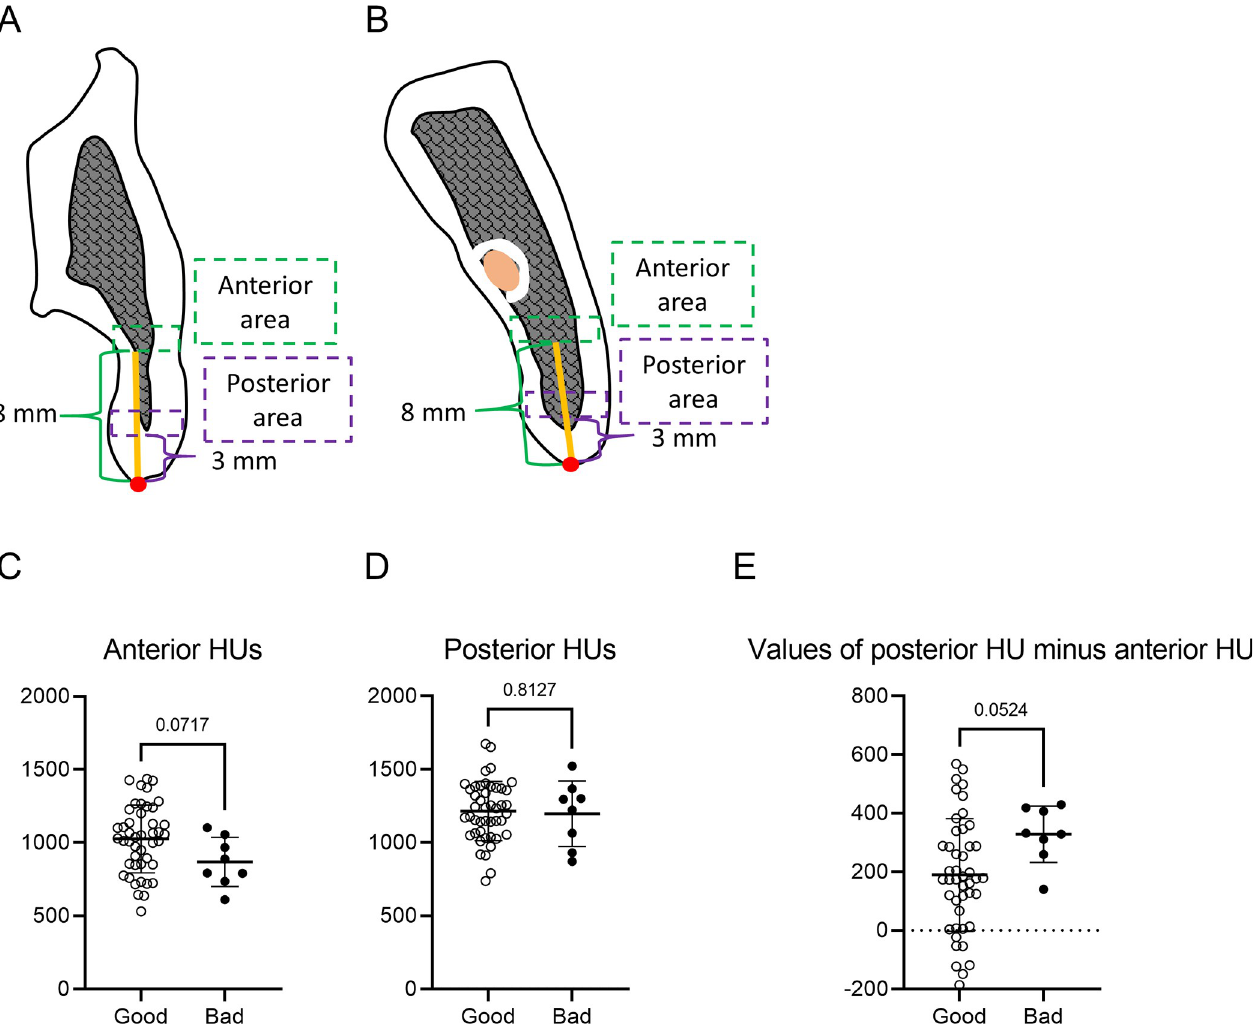
Fig 4. Analysis of HUs in the ramus. HUs were measured in 2 rectangular areas at the height of the lingula of the mandible (A) and the mandibular foramen (B) . The rectangle was located 3 mm (anterior area) or 8 mm (posterior area) in front of the backward point. The rectangle width was set at 1.5 mm, and the length was defined as the distance from the buccal surface to the lingual surface. Anterior HUs (C) and posterior HUs (D) of the 2 groups, measured from Images A and B, respectively. (E) Values of posterior HU minus anterior HU of the 2 groups. Data are presented as mean ±